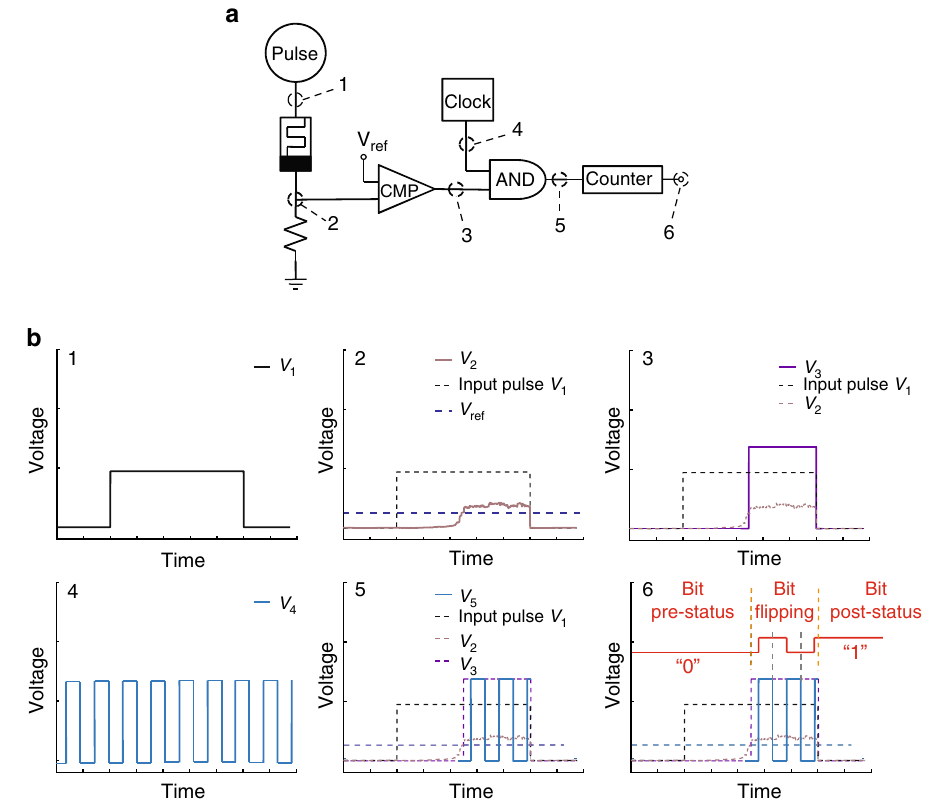
Fig. 2 Working principle of a diffusive memristor based true random number generator (TRNG). a Circuit diagram of a TRNG with a diffusive memristor, a comparator (CMP), an AND gate, and a counter. b Schematic pulse waveforms at each stage of the circuit (as labeled in a ), illustrating the